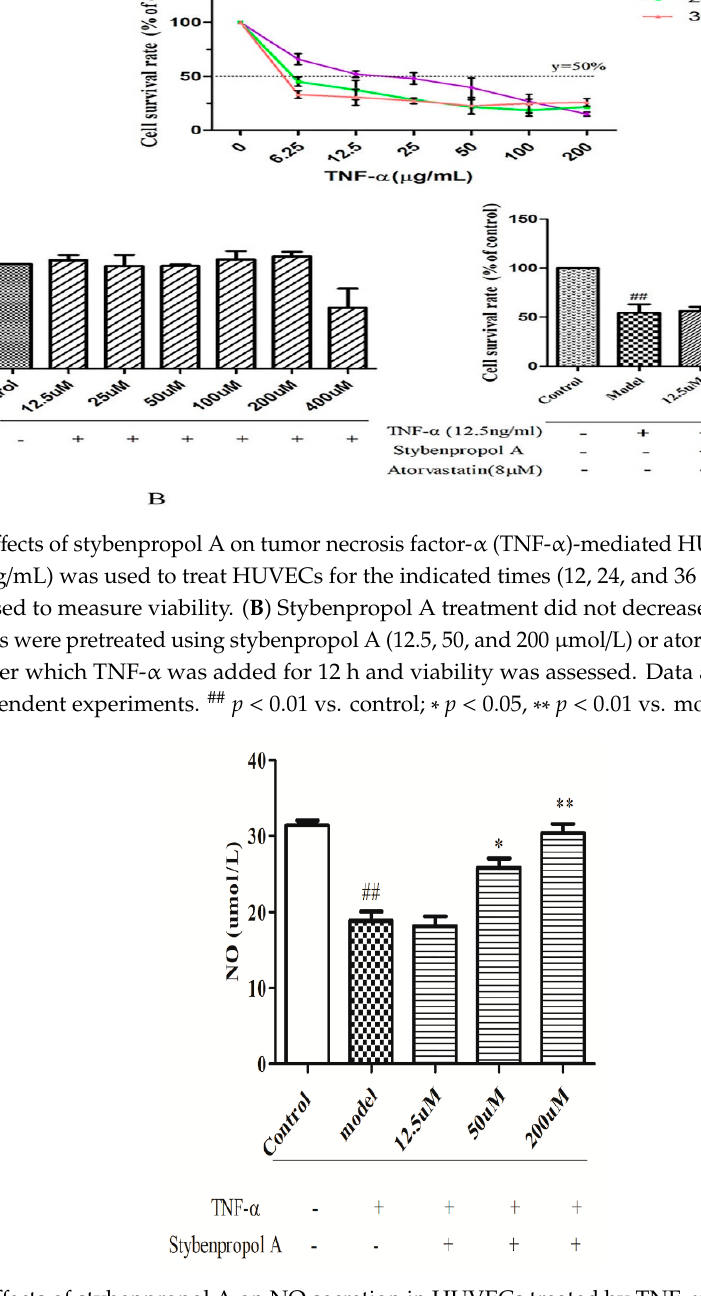
Figure 4. Effects of stybenpropol A on NO secretion in HUVECs treated by TNF- α . Following a 24-h pretreatment with stybenpropol A (12.5, 50, 200 μ M), HUVECs were treated with TNF- α and levels